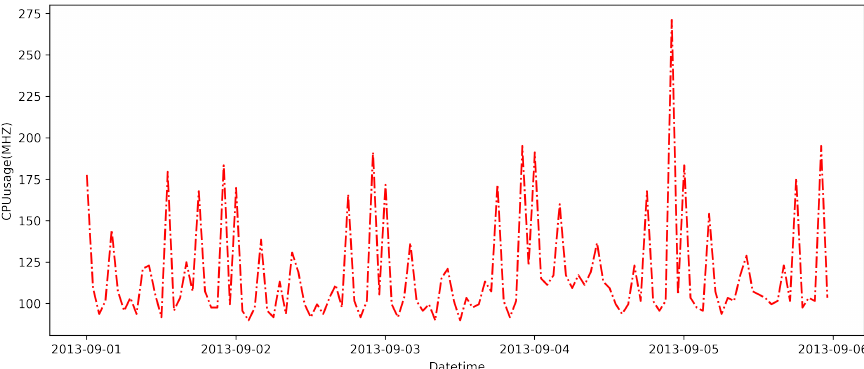
Figure 5. Behaviour of actual CPU usage.